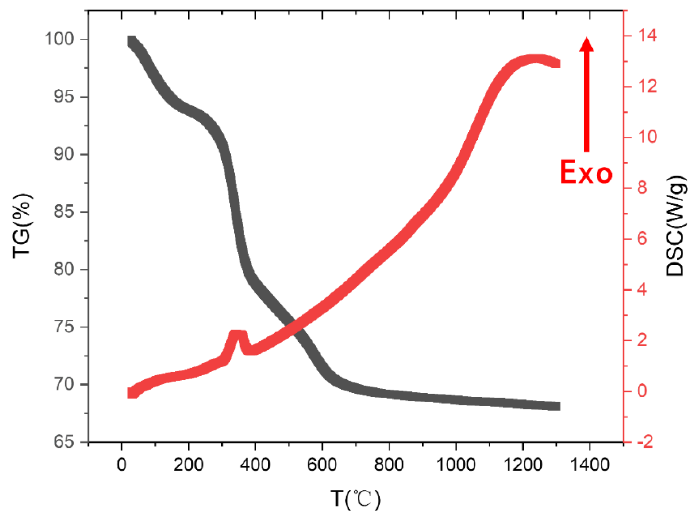
Figure 2. Plot of TG-DSC data for the precursors of hydrothermal powders. The initial amount of the sample was 8.767 mg.